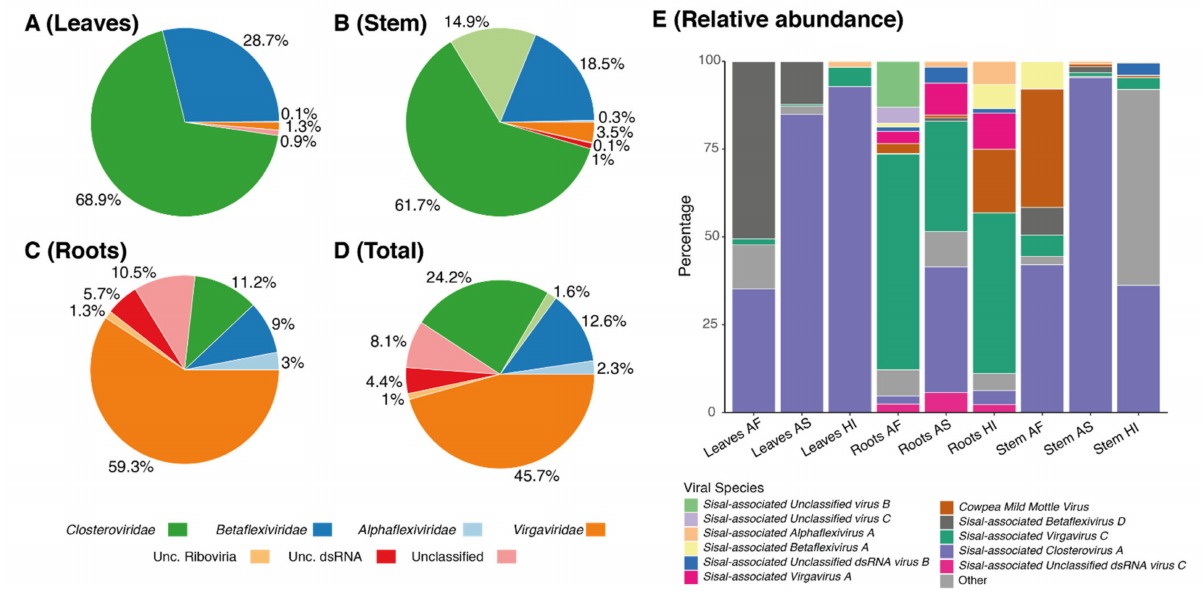
Figure 5. Viral abundance of Agave-associated viruses by organ. Pie charts indicate viral family abundance by expression in tpm, in ( A ): leaves, ( B ): stems, ( C ): roots, and ( D ): in total. Values are summed for all plants. ( E ): The stacked bar plot indicates the relative abundance of the top 12 expressed viral species in each organ.